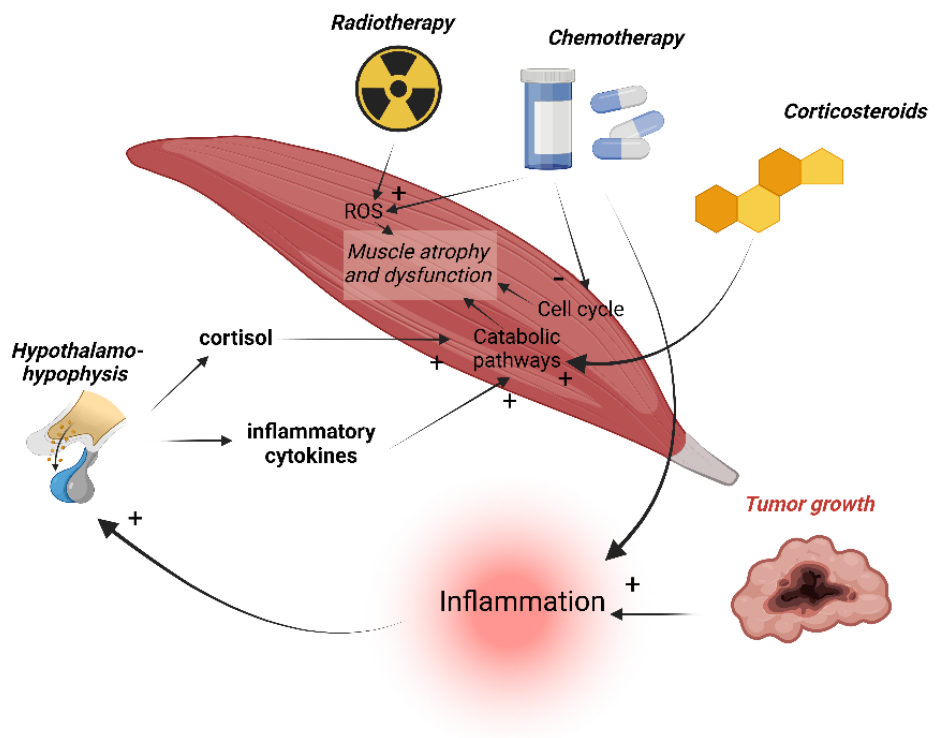
Figure 6. Schematic of the muscle direct- or indirect-related toxicities (muscle atrophy and dysfunc- tion) induced by cancer and anti-cancer treatments (radiotherapy, chemotherapy, corticosteroids). The + symbols represent a stimulation/induction and the – symbols, an inhibition. Created with BioRender.com.